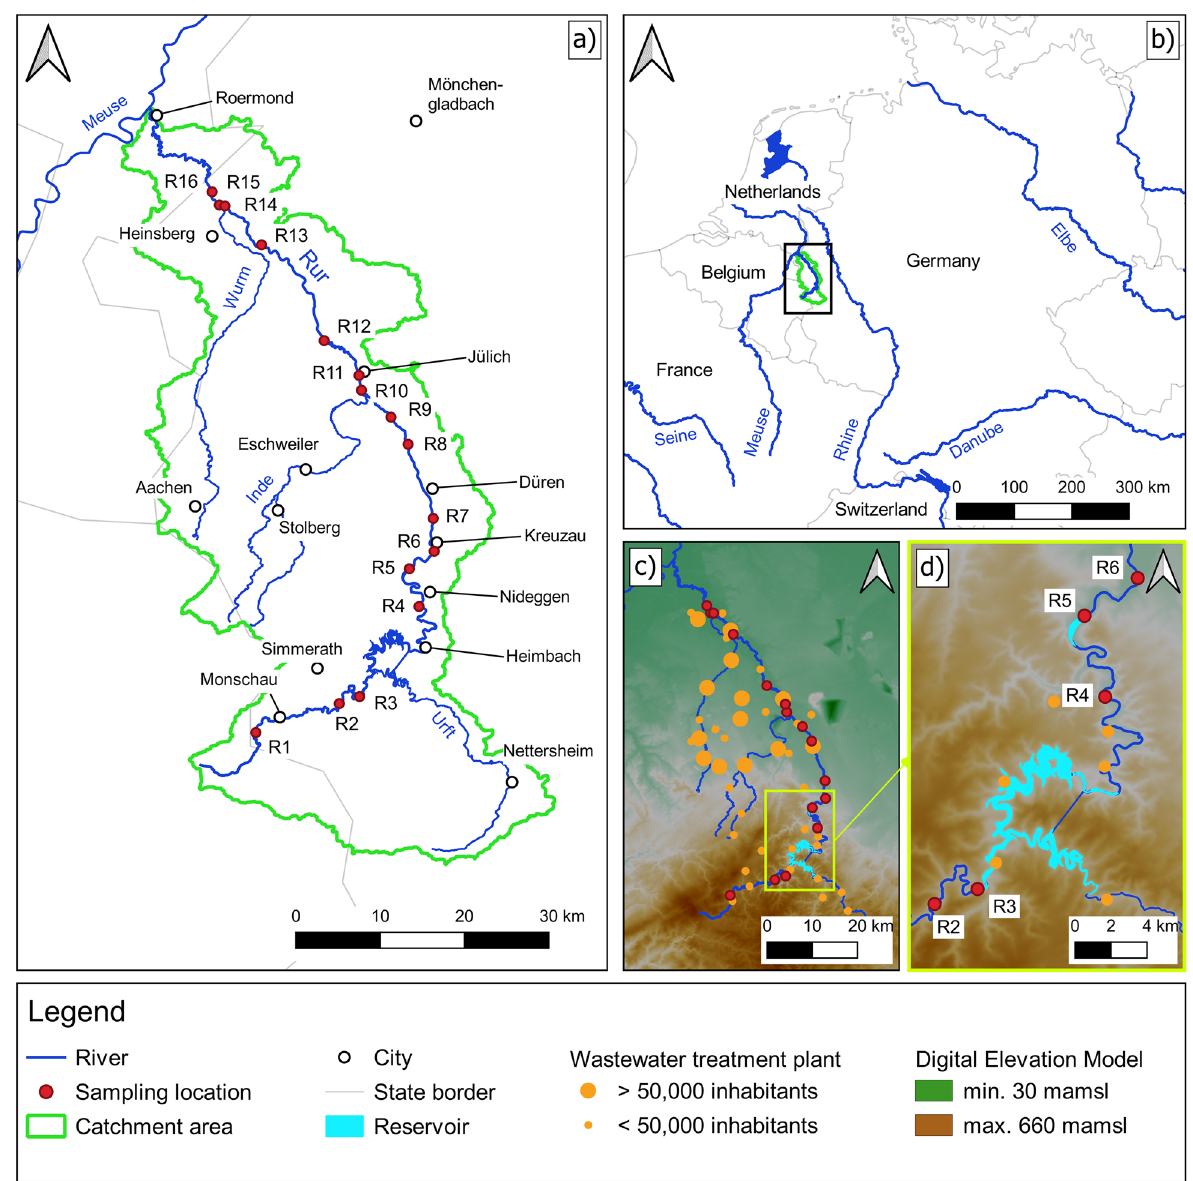
Fig. 1 Overview of the Rur catchment. a Rur catchment with sampling locations and important tributaries, b location of the Rur catchment in an European context, c wastewater treatment plants and elevations (meters above mean sea level, mamsl), d reservoirs in the upper course of the